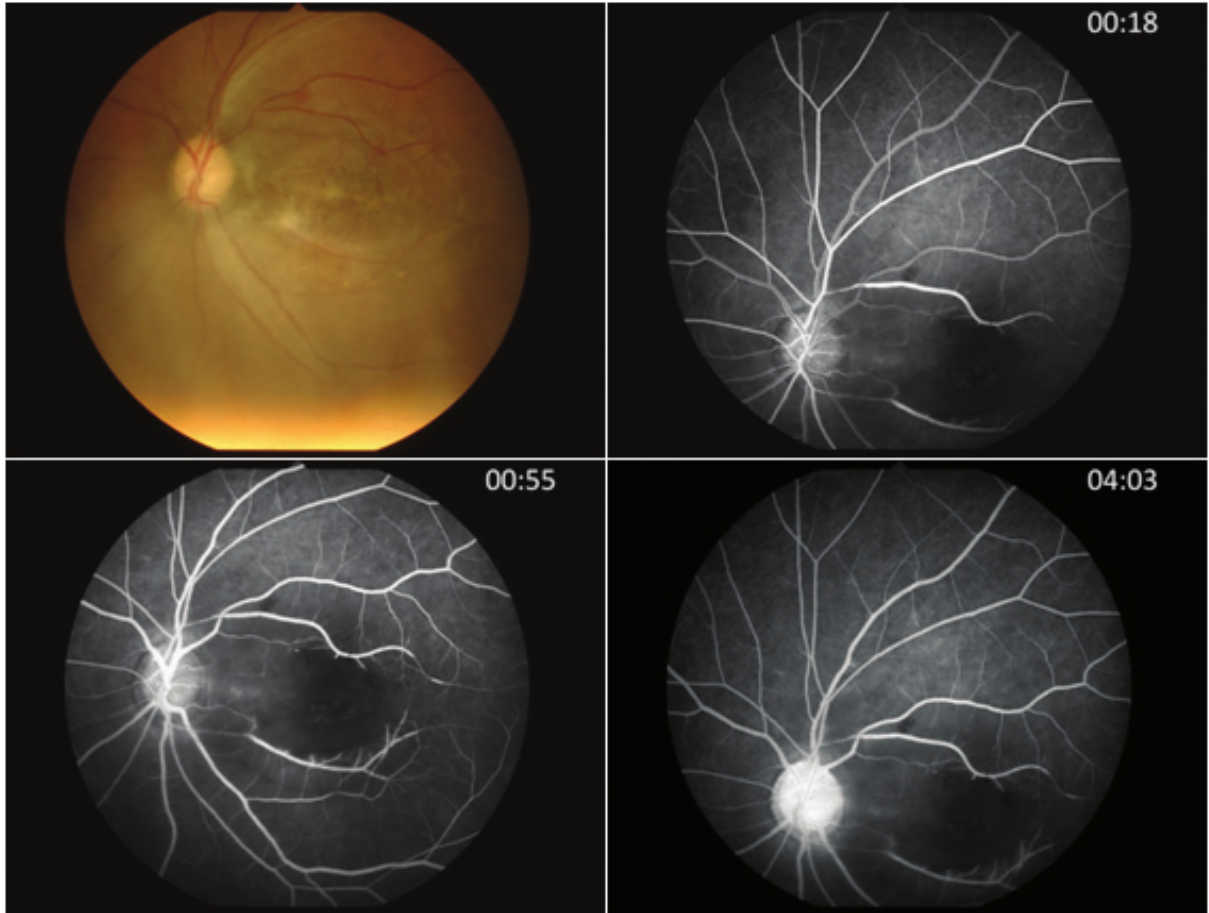
Figure 3. Fundus photograph and fluorescein angiography of the left eye showed resolutions of retinal whitening, generalized attenuation of retinal vessels especially inferotemporal branch, and atrophic macula with clumping pigment. Optic disc appeared slightly pale and